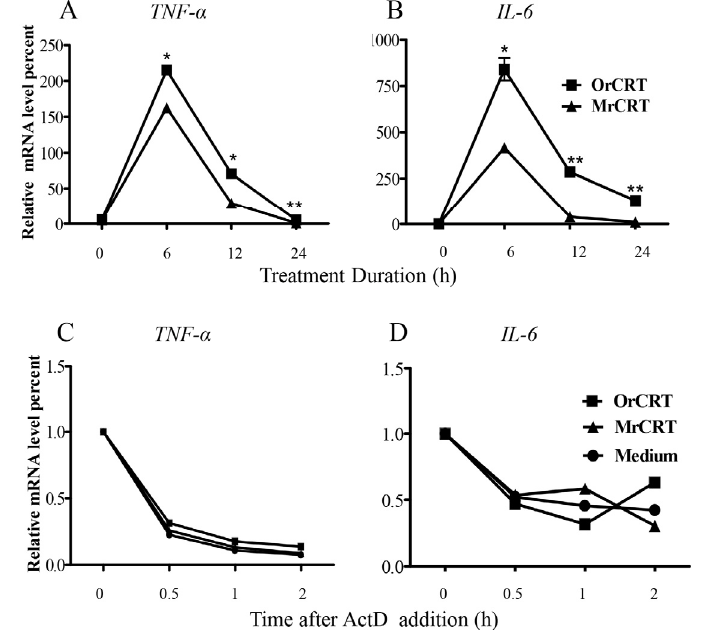
Figure 2. Effect of rCRTs on TNF- α and IL-6 mRNA expression in macrophages. ( A , B ) Macrophages were stimulated by 10 μ g/mL MrCRT or OrCRT for 0, 6, 12, and 24 h before harvesting for RNA isolation; ( C , D ) macrophages were treated with 10 μ g/mL MrCRT or OrCRT for 6 h, after which Actinomycin D (5 μ g/mL) was added and cells incubated further for 0, 0.5, 1, or 2 h before RNA extraction. TNF- α and IL-6 mRNA levels were determined by real-time PCR. Results are expressed as mean ± SD of three independent experiments. * p < 0.05, ** p < 0.01 OrCRT group vs . MrCRT